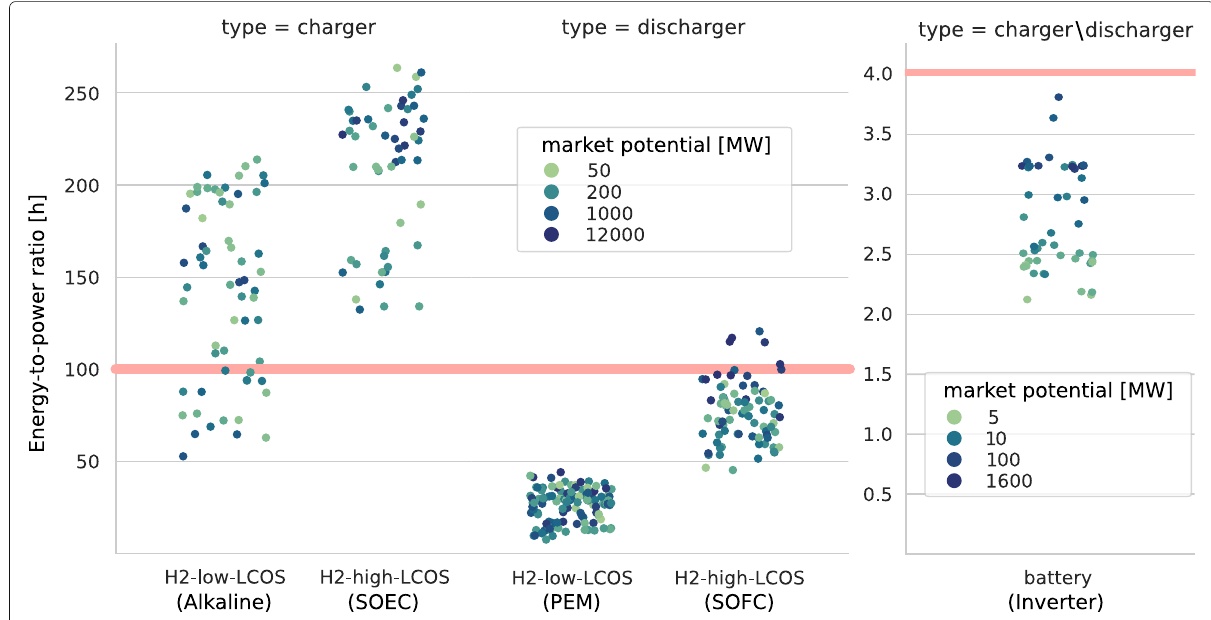
Fig. 7 Optimal energy to power ratio ranges in the variable EP ratio scenario. The red line represents the fixed EP-ratio scenario assumption. The energy to power ratios are very diversely sized in the 181 buses of the cost-optimal European system layout and in regards to hydrogen and not necessarily equal for charger and discharger. The electrolyser capacity is generally smaller than the fuel cell capacity, which means that slow charging and quick discharge at few moments is desired in the